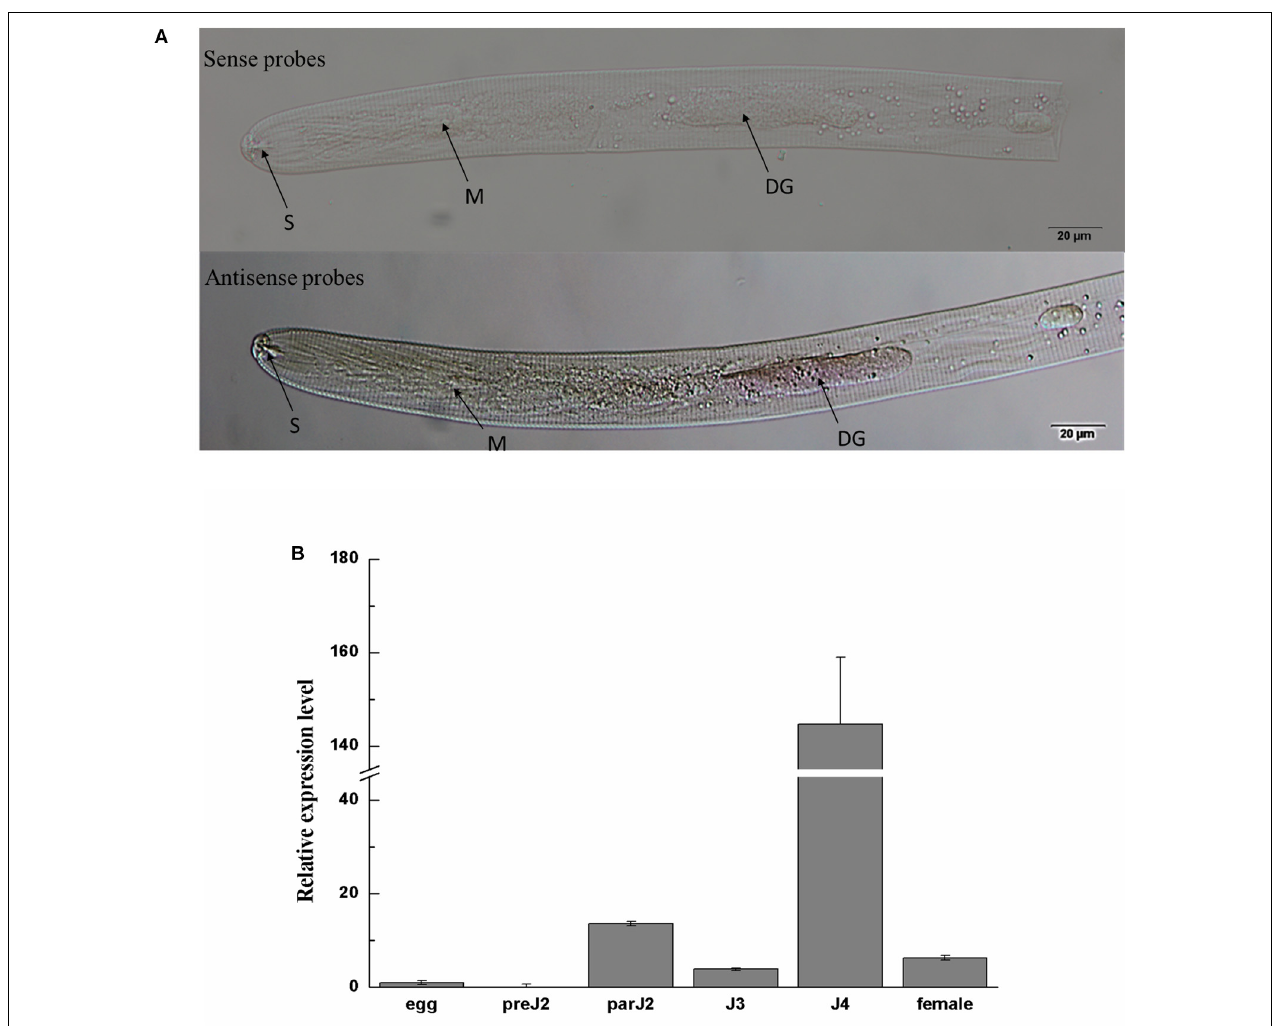
FIGURE 2 | Spatial and developmental expression of Ha-18764 . (A) Localization of Ha18764 mRNA in the dorsal gland of pre-parasitic second stage juveniles of Heterodera avenae by in situ hybridization. The dorsal gland (DG), metacorpus (M), and stylet (S) are indicated with arrows. (B) Developmental expression pattern of Ha18764 . The relative expression level of Ha18764 was quantified using qPCR for six different H. avenae stages. The fold-change values were calculated using the 2 − (cid:49)(cid:49) Ct method and presented as the change in mRNA level in various nematode developmental stages relative to that of egg. Each column represents the mean ( ± SD) of three samples. This experiment was independently repeated three times, with consistent results. pre-J2, pre-parasitic second-stage juvenile; par-J2, J3, J4, parasitic second-, third- and fourth-stage juveniles,